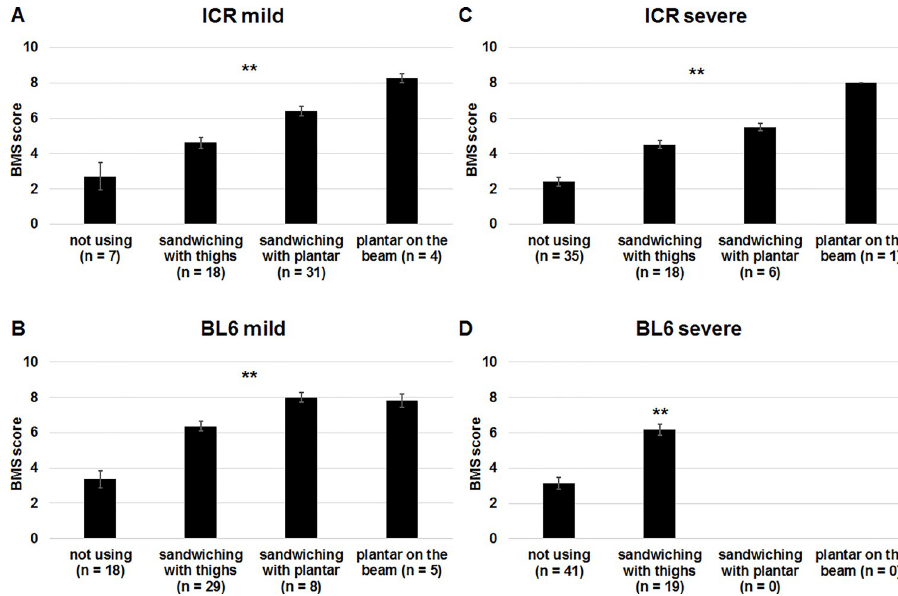
Fig 4. Comparison of BMS scores among mice with different positions of hindlimbs on the beam after SCI. ICR (A, C) and C57BL/6 (B, D) mice 1 day, and 1, 2, 3 and 4 weeks after mild (A, B) and severe (C, D) SCI were divided into 4 groups according to positions of hindlimbs; (i) mice which could not use hindlimbs, (ii) those which sandwiched the beam from the both sides with thighs, (iii) those which sandwiched the beam from the both sides with plantar, (iv) those which put plantar on top of the beam. BMS scores of the groups were compared. Kruskal-Wallis test with Steel-Dwass analysis or Mann-Whitney U test, �� p < 0.01.